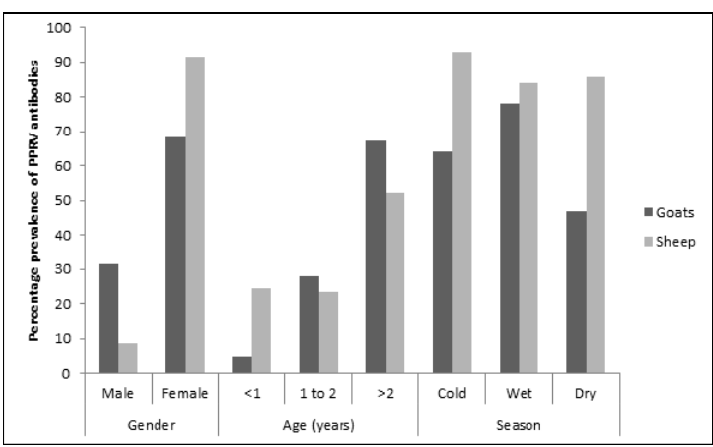
Figure-1. Gender, age and seasonal distribution of PPR VN antibodies among small ruminants in the semi-arid NE zone of